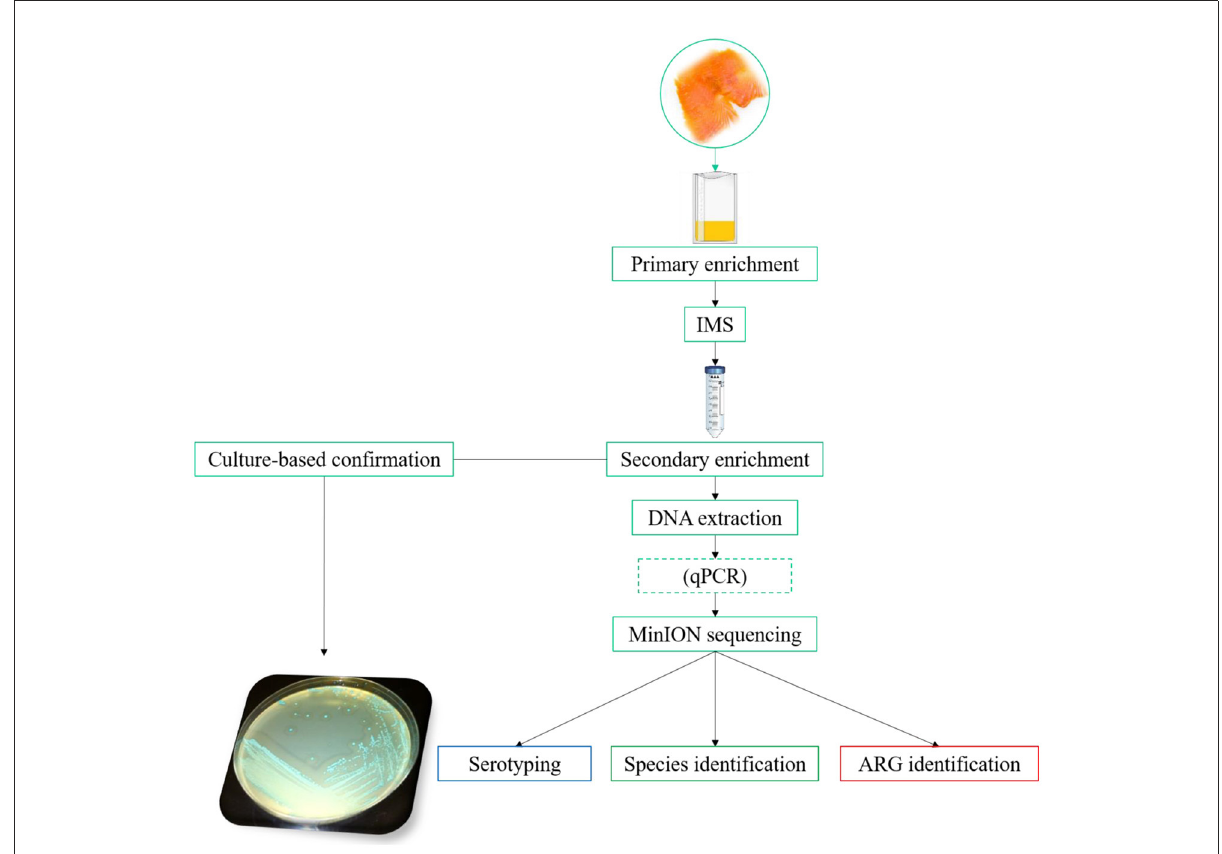
FIGURE1 General workflow. For the “primary enrichment,” HF and ONE broth Listeria were compared. In the “IMS” step, the commercial Dynabeads ® anti- Listeria was compared with MNP functionalized with a mAb. The dashed box for “qPCR” indicates that this step is optional. The “antimicrobial resistance” pipeline, available from EPI2ME, for the MinION data analysis implements WIMP and CARD for species/ serotype identification and antimicrobial resistance gene detection, respectively.